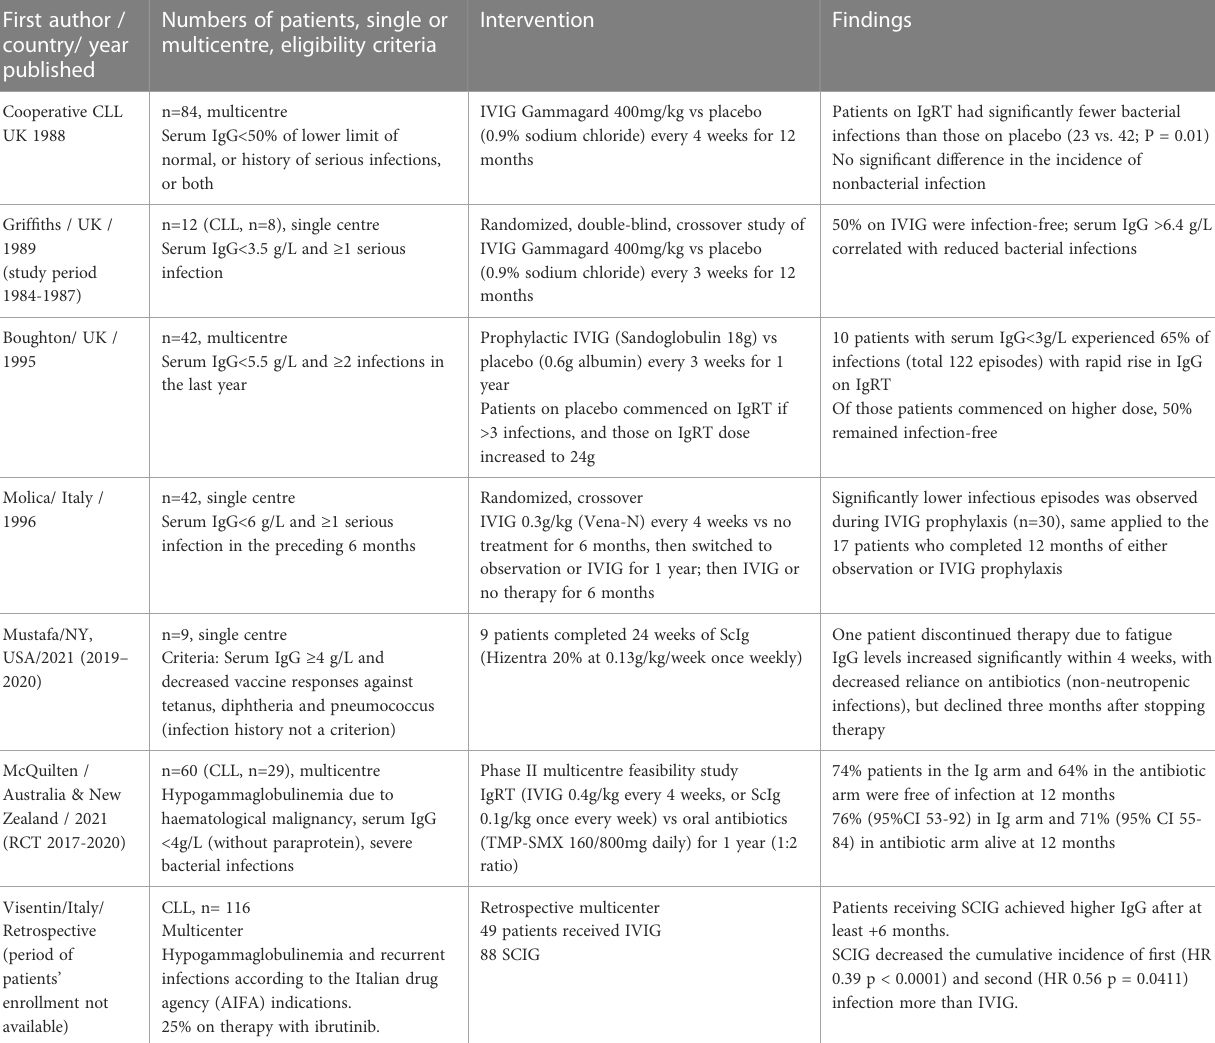
TABLE 1 Randomised clinical trials on effect of immunoglobulin replacement therapy in CLL patients with hypogammaglobulinemia (40, 43, 45 –